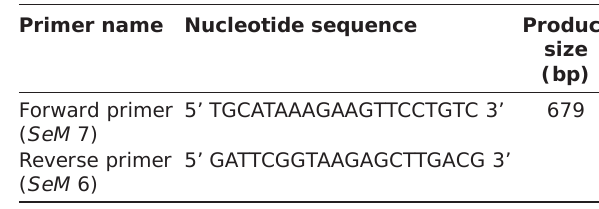
Table-1: List of oligonucleotide primers for detection of SeM gene (Timoney and Artiuschin,